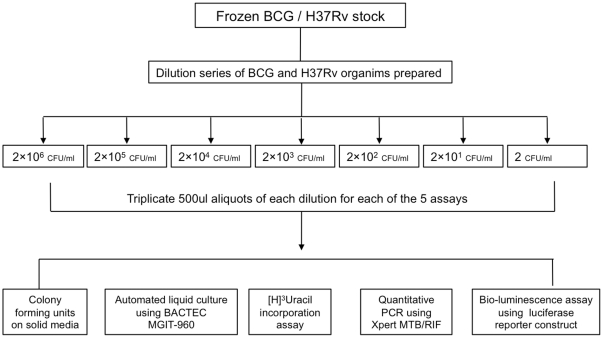
Preparation of Mycobacterial dilutions for load determination assays.A three-milliliter volume of frozen stock was diluted to a working suspension of 2×106 CFU/ml. From this stock 5 serial dilutions were prepared ranging from 2 to 2×106 CFU/ml. From these dilutions, 15 aliquots of organisms were prepared containing 1 to 1×106 CFU in 500 ul. Three aliquots of each dilution were used in each of the 5-mycobacterial load determination assays as described in the methods section. PCR-polymerase chain reaction, MGIT mycobacterial growth indicator tube, CFU-colony forming unit.